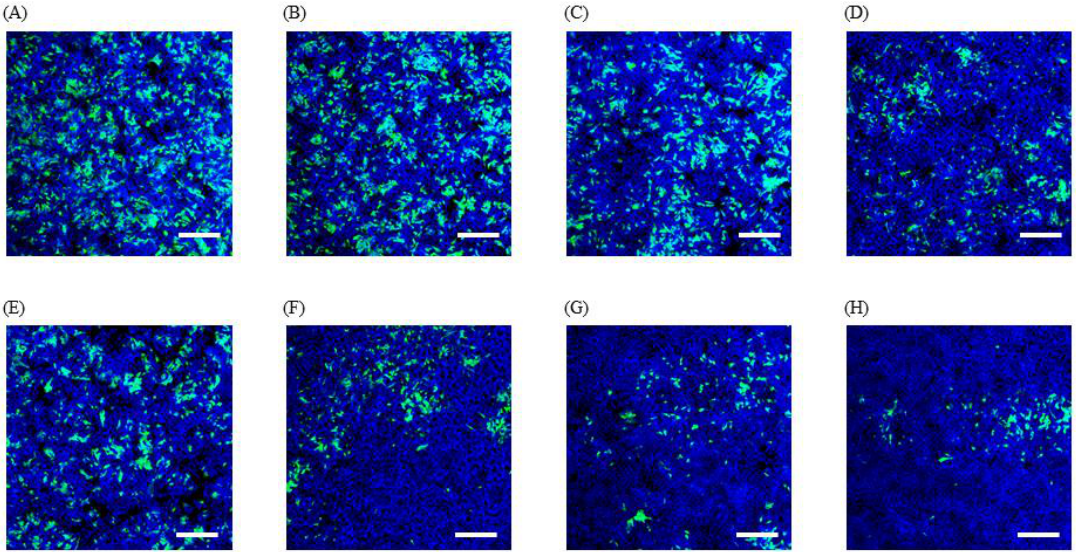
Figure 2. Images of immunofluorescence assay (IFA) using virus solutions from photocatalytic uncoated ( A – C ) and coated ( D – H ) films harvested every 1 h with or without 1000 lux light irradiation for 4 h. Twenty-two hours after inoculation with the collected virus solutions, cells were stained with anti-BCoV (bovine coronavirus) rabbit serum followed by goat FITC (fluorescein isothiocyanate) conjugate anti-rabbit IgG, IgA, and IgM (green), and with DAPI (4,6-diamidino-2-phenylindole) (blue). ( A ) photocatalytically uncoated films after 0 h without visible light of 1000 lux, ( B ) photocatalytically uncoated films after 4 h without visible light of 1000 lux, ( C ) photocatalytically uncoated films after 4 h with visible light of 1000 lux, ( D ) photocatalytic-coated films after 4 h without visible light of 1000 lux, ( E – H ) photocatalytic-coated films after 1 h ( E ), 2 h ( F ), 3 h ( G ), and 4 h ( H ) with visible light of 1000 lux. Scale bar represents 100 μm.